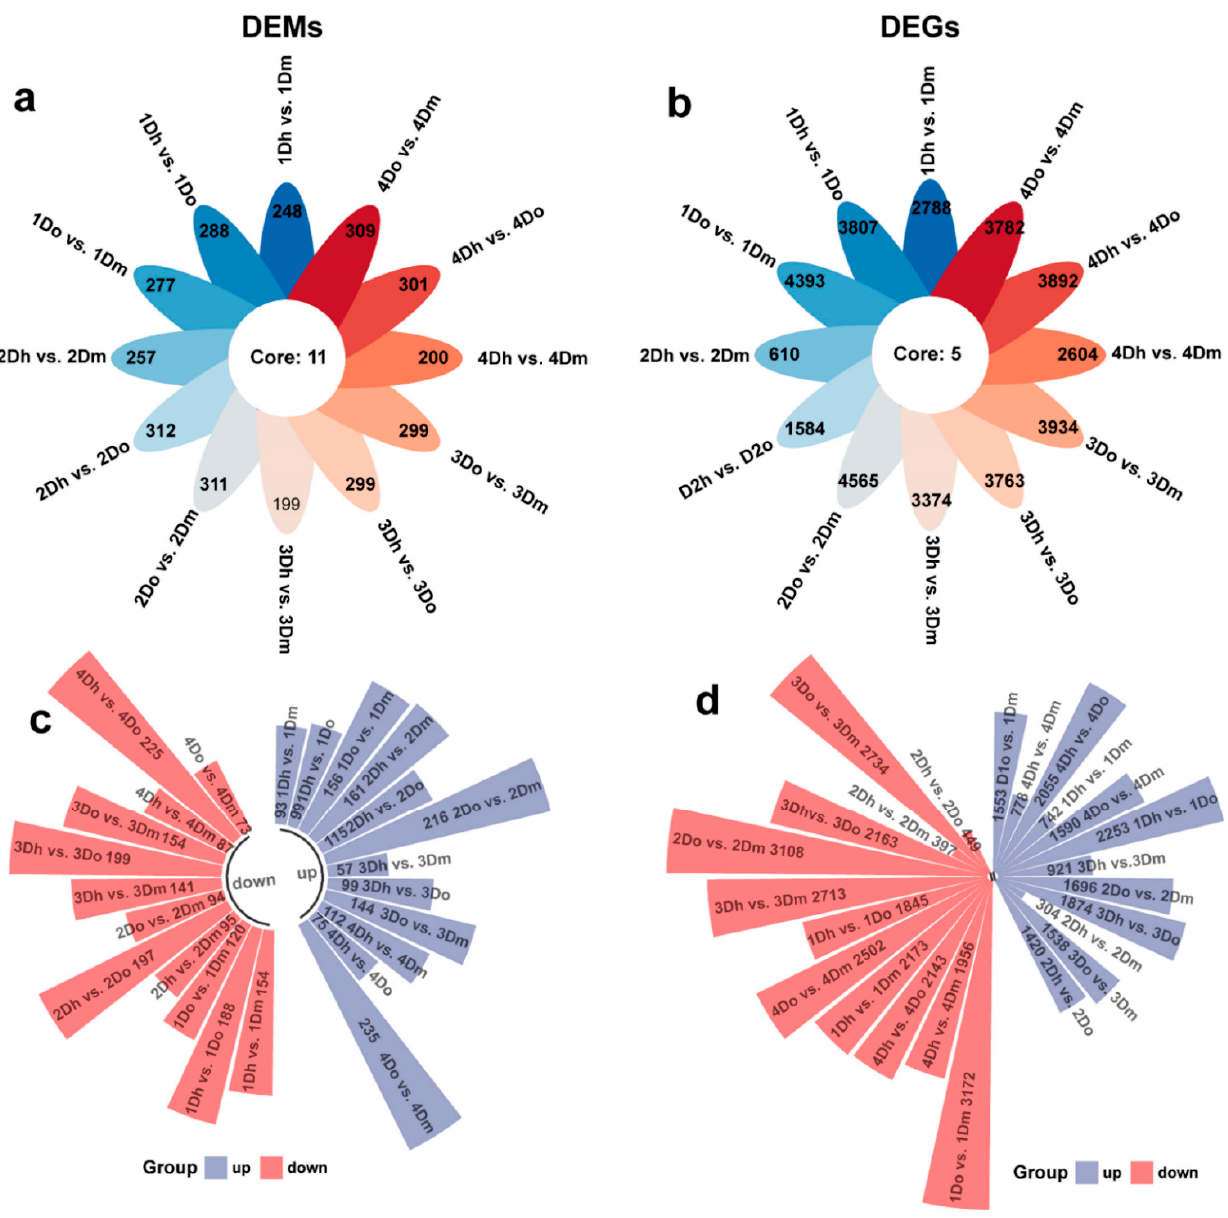
Figure 2. Changes in the number of DAMs and DEGs in 12 comparison groups. The total number of DAMs ( a ) and DEGs ( b ) in different comparison groups is calculated. The number in the center represents the number of DAMs/DEGs shared by all comparison groups. The number of DAMs ( c ) and DEGs ( d ) that are upregulated and downregulated in different comparison groups is compared. Blue represents downregulation and red represents upregulation.